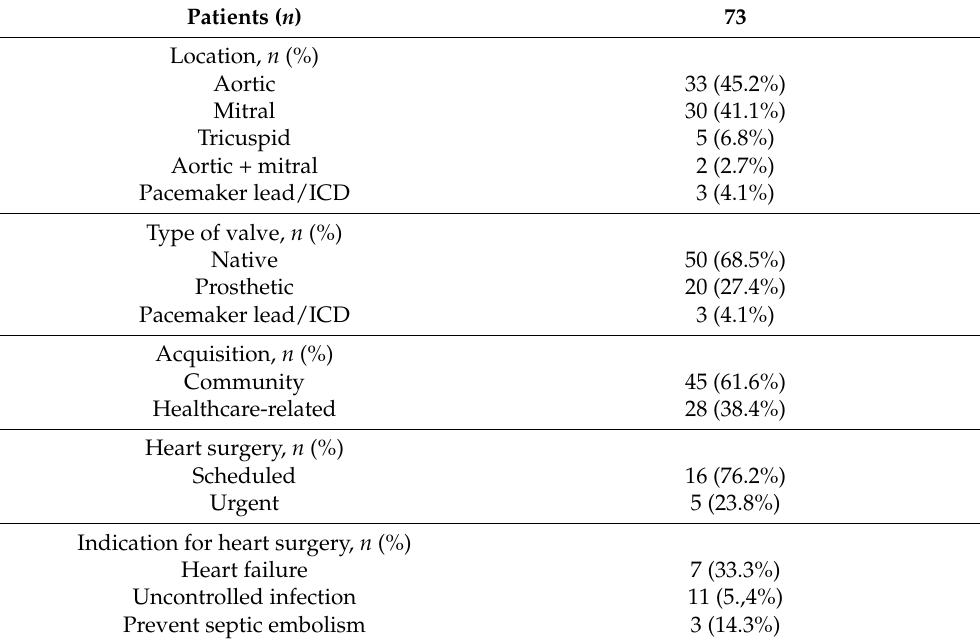
Table 4. Characteristics of IE cases (Definite and